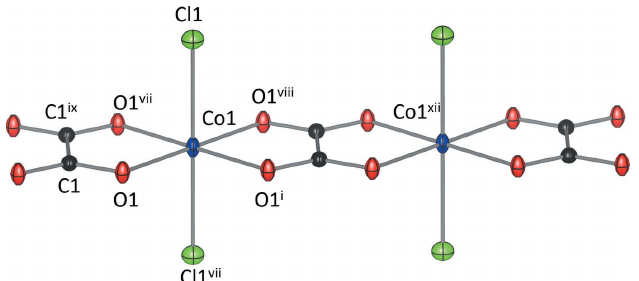
Figure 3 Coordination environment of Co 2+ in Rb 2 CoCl 2 (C 2 O 4 ) (II). Colour code: Co (blue), Cl (green), C (black) and O (red). Displacement ellipsoids are drawn at 50% probability level. [Symmetry codes: (i) (cid:3) x + 1, y , (cid:3) z + 1; (vii) x , (cid:3) y + 2, z ; (viii) (cid:3) x + 1, (cid:3) y + 2, (cid:3) z + 1; (ix) (cid:3) x + 2, (cid:3) y + 2, (cid:3) z + 1; (xii) x (cid:3) 1, y , z ].